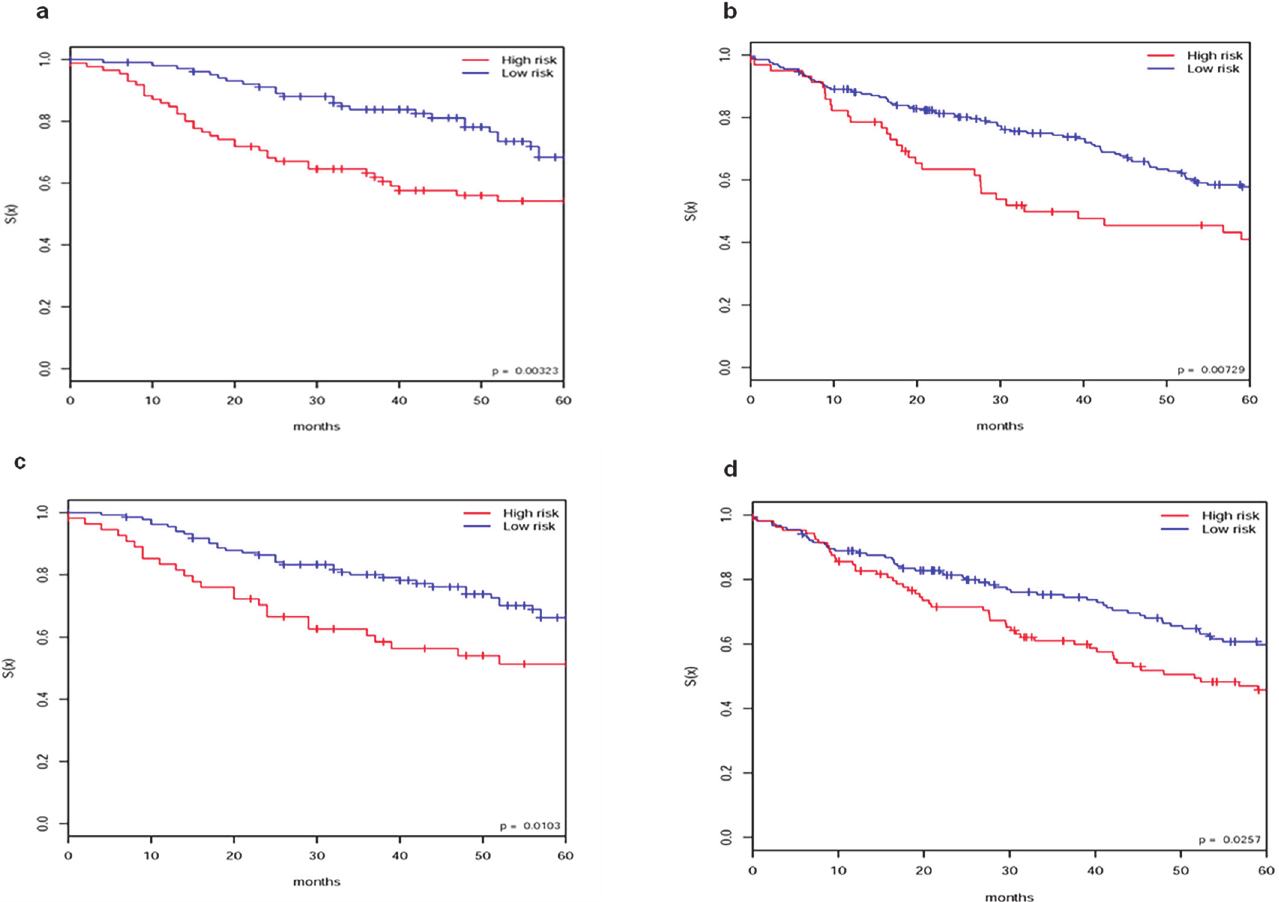
Fig 4. Consistent TM clusters and consistent HM clusters . (a) TM clusters and (b) HM clusters. Kaplan-Meier plots of the two consistent TM clusters and the two consistent HM clusters from our clustering approach with CSD (decomposition noise level is 20,000) and MBI (10 runs with parameter k 2 = 2). (c) Sample classification of TM samples using the 128 genes, based on the subtypes of HM, and (d) Sample classification of HM samples using the 128 genes, based on the subtypes of TM. TM and HM cross-validation (CV) using 128 genes (where 128 genes are identified from all genes based on clusters of MBI 10 runs on TM and MBI 10 runs on HM; For cross-validation, least square based sample prediction is applied).